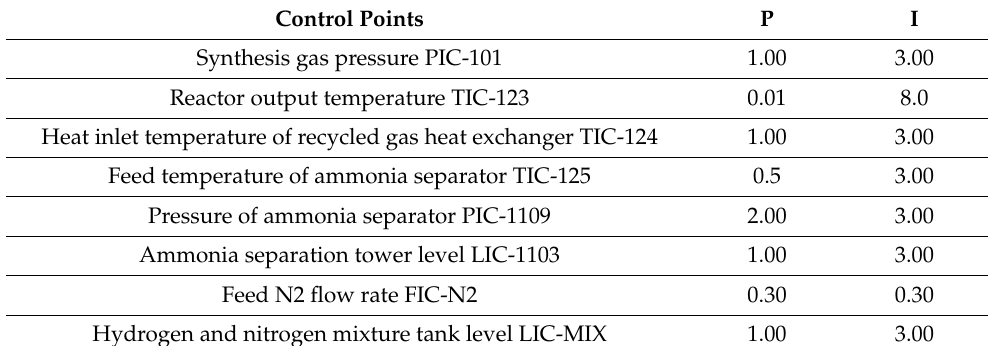
Table 6. PID main control